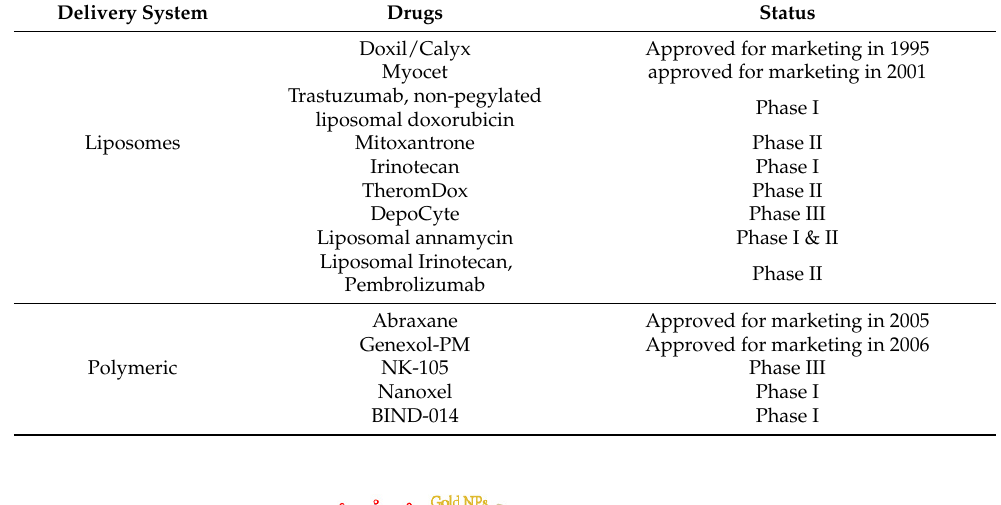
Table 1. Nanoparticles approved or currently in clinical trials for breast cancer.